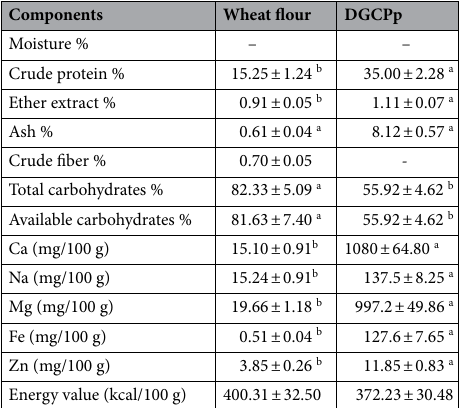
Table 1. Proximate chemical composition of wheat flour and DGCPp on a dry weight basis. Data are expressed as mean ± SEM. Mean values with different superscript letters [a (the highest values)—b (the lowest value)] in the same row are significantly different at ( p ≤